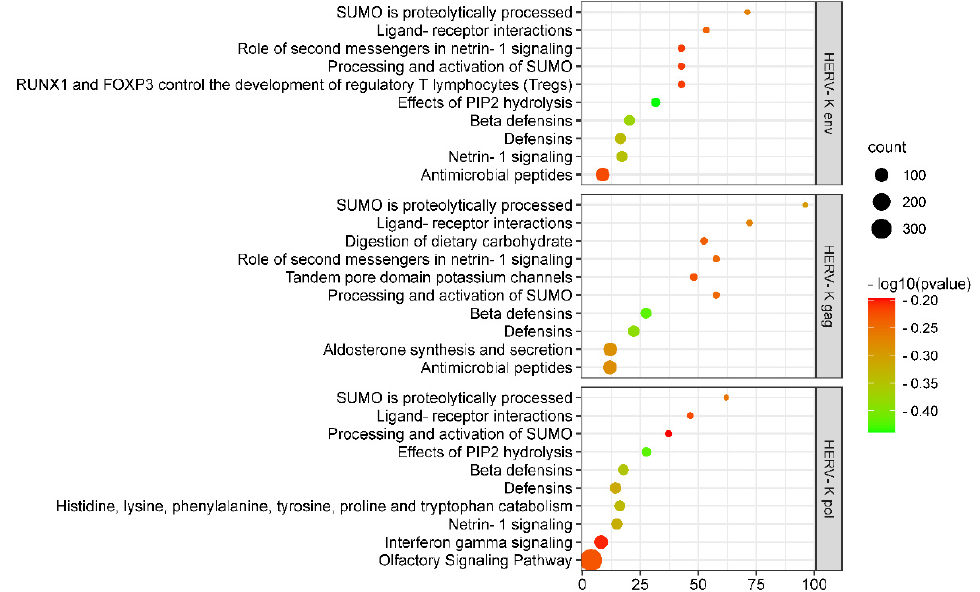
Figure 5. Scatter plot of enriched KEGG pathway statistics. The colour and size of the dots represent the range of the Q − value and the number of DEGs mapped to the indicated pathways, respectively. The top 10 enriched pathways are shown in the figure.